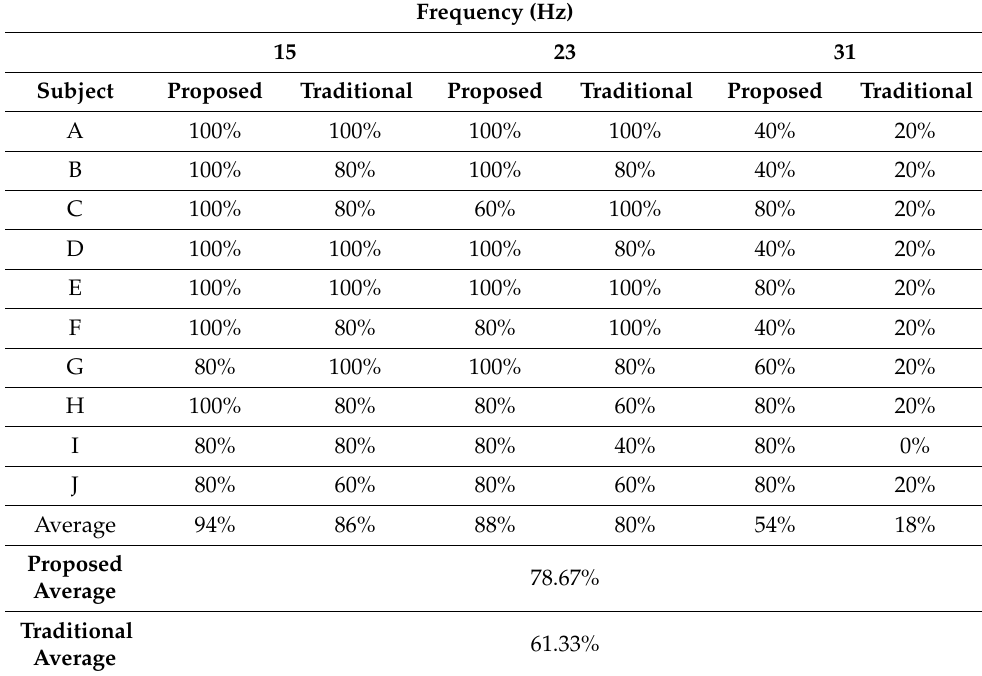
Table 7. Comparison of the accuracy of the traditional method and the proposed